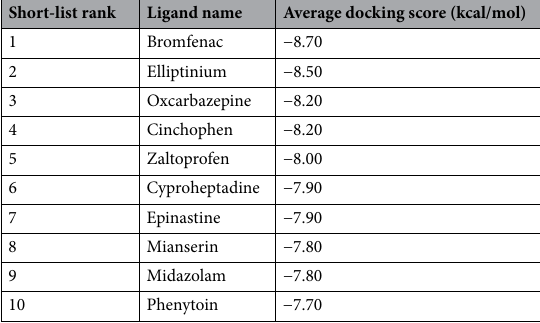
Table 1. Docking Score of the Top 10 Ligands.